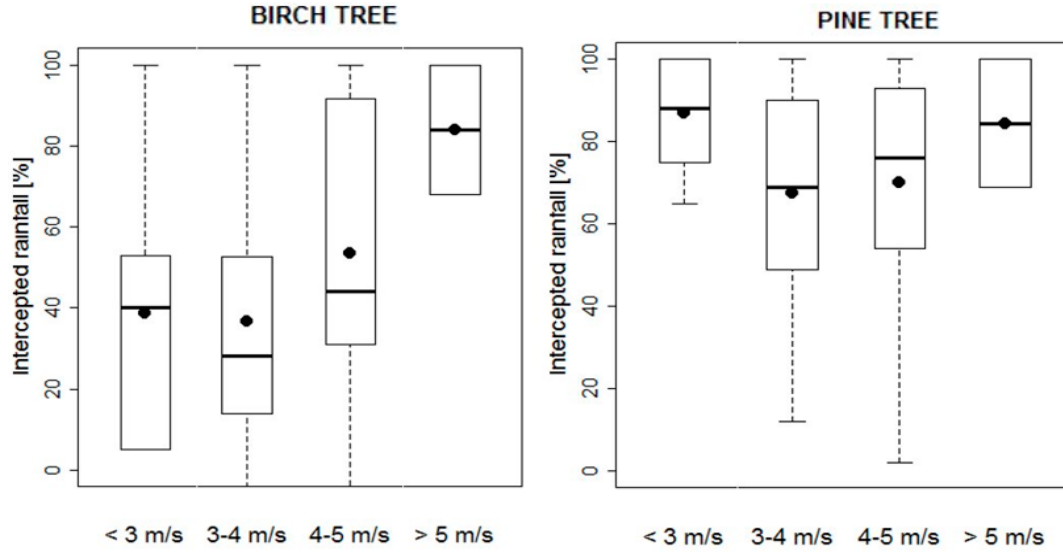
Figure 5. Box plot of rainfall interception according to average event’s drop velocity